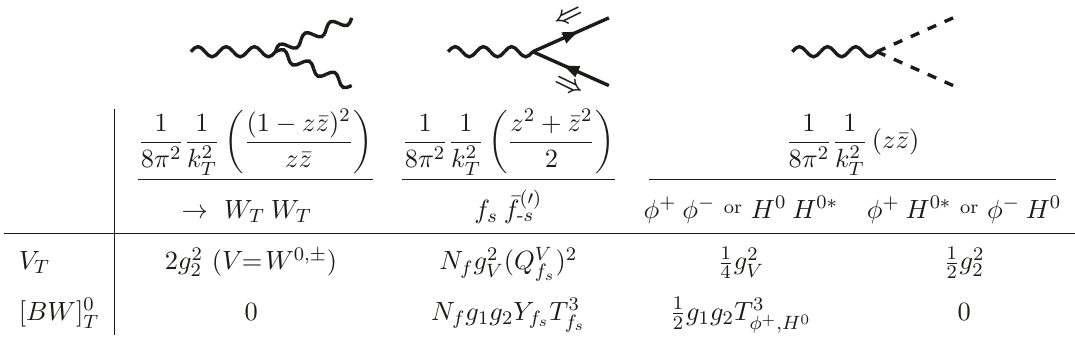
/dz dk 2 in the massless limit, where T P